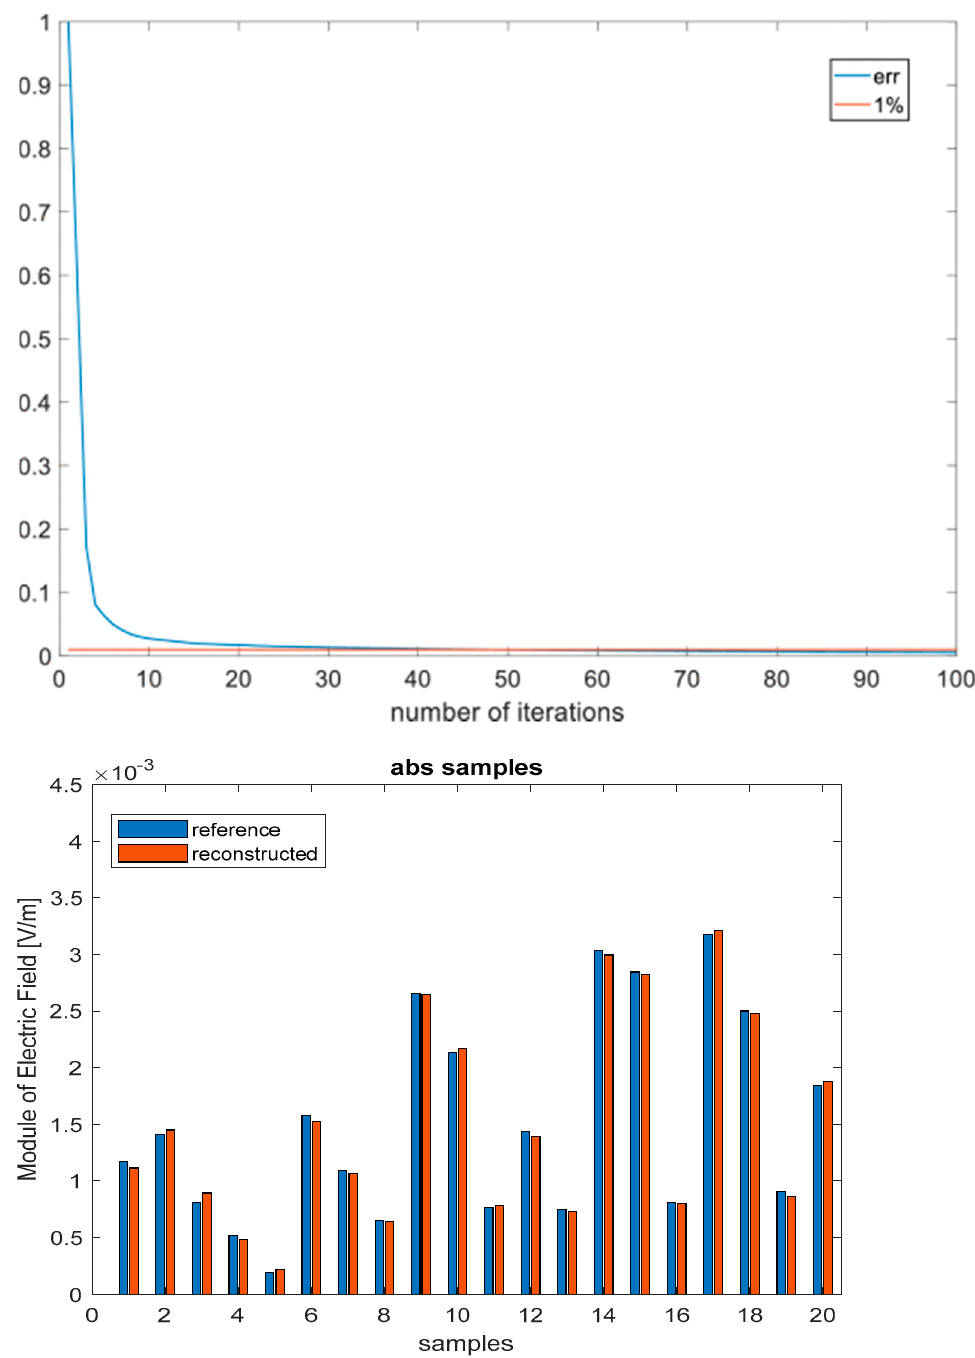
Figure 5. Relative error (err) on the reconstruction of the electric field at samples’ position in function of iterations (up) and reference and reconstructed electric field samples (down).